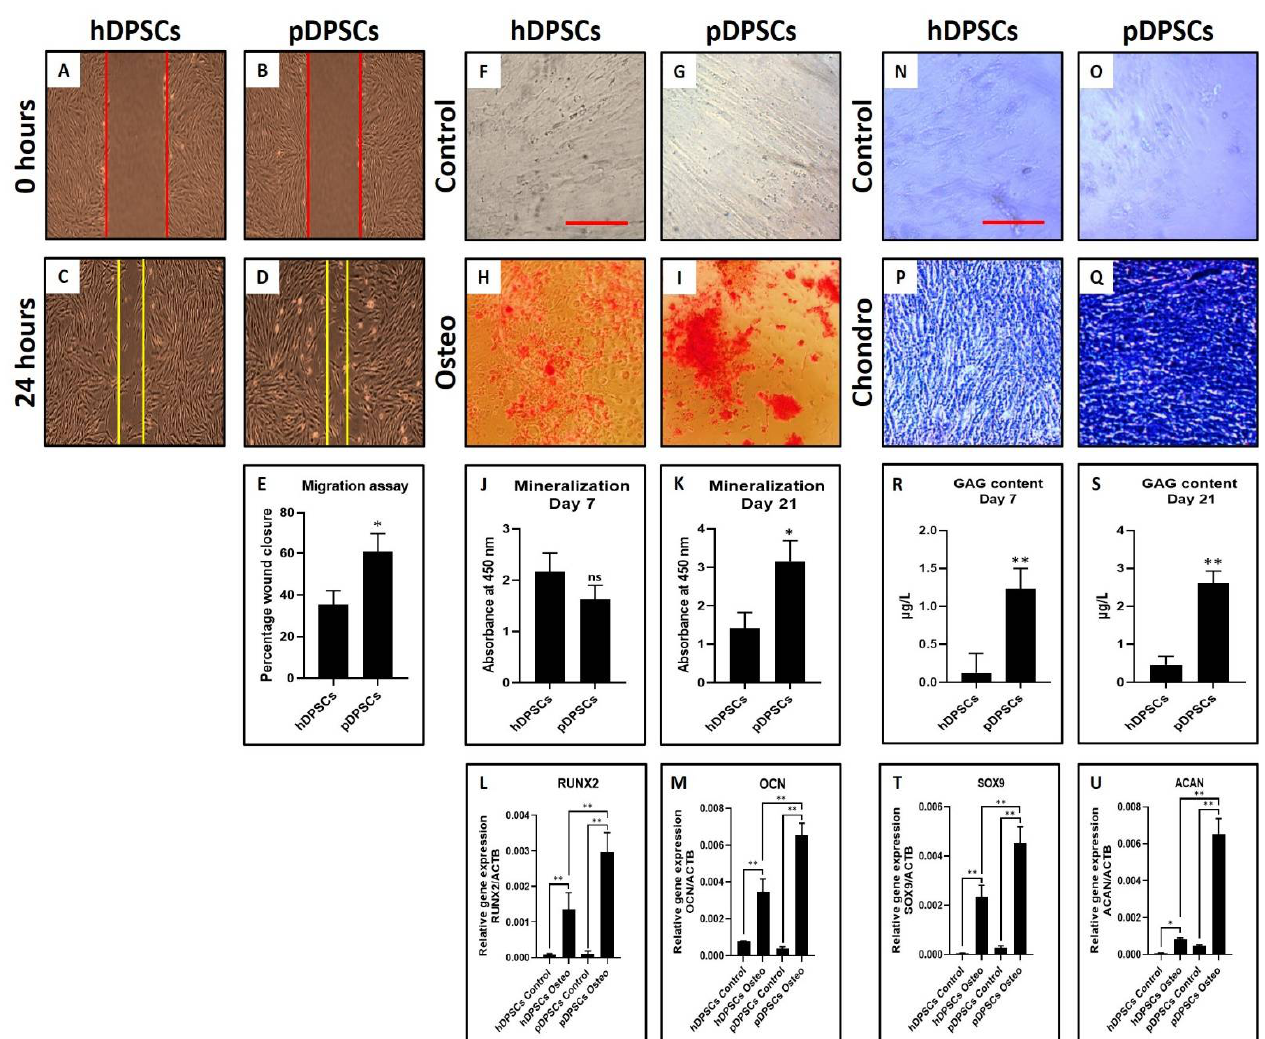
Figure 4. Assessment of migration, osteogenic differentiation and chondrogenic differentiation in DPSCs from healthy and periodontitis-affected teeth at Passage 6. ( A – E ) comparative analysis of the migratory ability of hDPSCs and pDPSCs. ( F – I ) comparative analysis of osteogenic differentiation in hDPSCs and pDPSCs. ( J , K ) comparative analysis of mineralization in osteogenically induced hDPSCs and pDPSCs at day 7 and day 21. ( L , M ) comparative analysis of osteogenesis-related genes RUNX2 and OCN in osteogenically induced hDPSCs and pDPSCs at day 21. ( N – Q ) comparative analysis of chondrogenic differentiation in hDPSCs and pDPSCs. ( R , S ) comparative analysis of GAG content in chondrogenically induced hDPSCs and pDPSCs at day 7 and day 21. ( T , U ) comparative analysis of chondrogenesis-related genes SOX9 and ACAN in chondrogenically induced hDPSCs and pDPSCs at day 21. Experiments were repeated in triplicates for n = 3. ns: not significant, * p < 0.05 and ** p < 0.01. hDPSCs: dental pulp stem cells from healthy teeth, pDPSCs: dental pulp stem cells from periodontitis-affected teeth, Osteo: osteogenic induction, RUNX2 : Runt-related transcription factor 2, OCN : osteocalcin, Chondro: chondrogenic induction, GAG: glycosaminoglycan, SOX9 : SRY-box transcription factor 9 and ACAN : aggrecan.